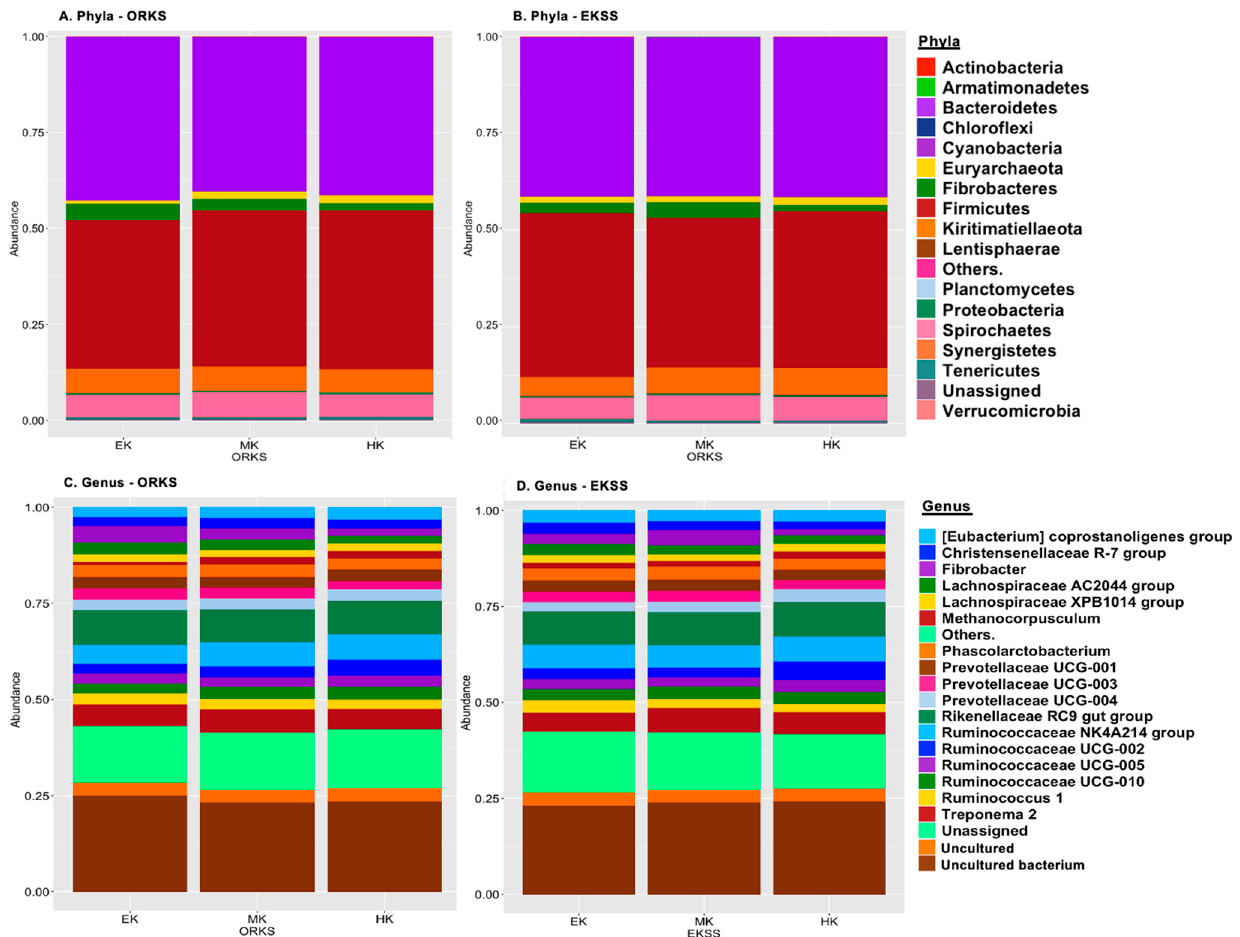
Figure 5. Relative abundance of the bacteria at the phyla level and the top 20 genera level bacteria present at rates >1%. Bacteria present at rates lower than 1% are represented by “Others.”. ( A ) Relative abundance of the top phyla in owner reported keeper statuses (ORKS). ( B ) Relative abundance at the phyla level in equine keeper status scale (EKSS) ( C ) Relative abundance of the top genera in ORKS. ( D ) Relative abundance of the top genera in EKSS. Table 4. Relative abundances of the ANCOM identified taxa to be differentially abundant between EKSS groups. EKSS